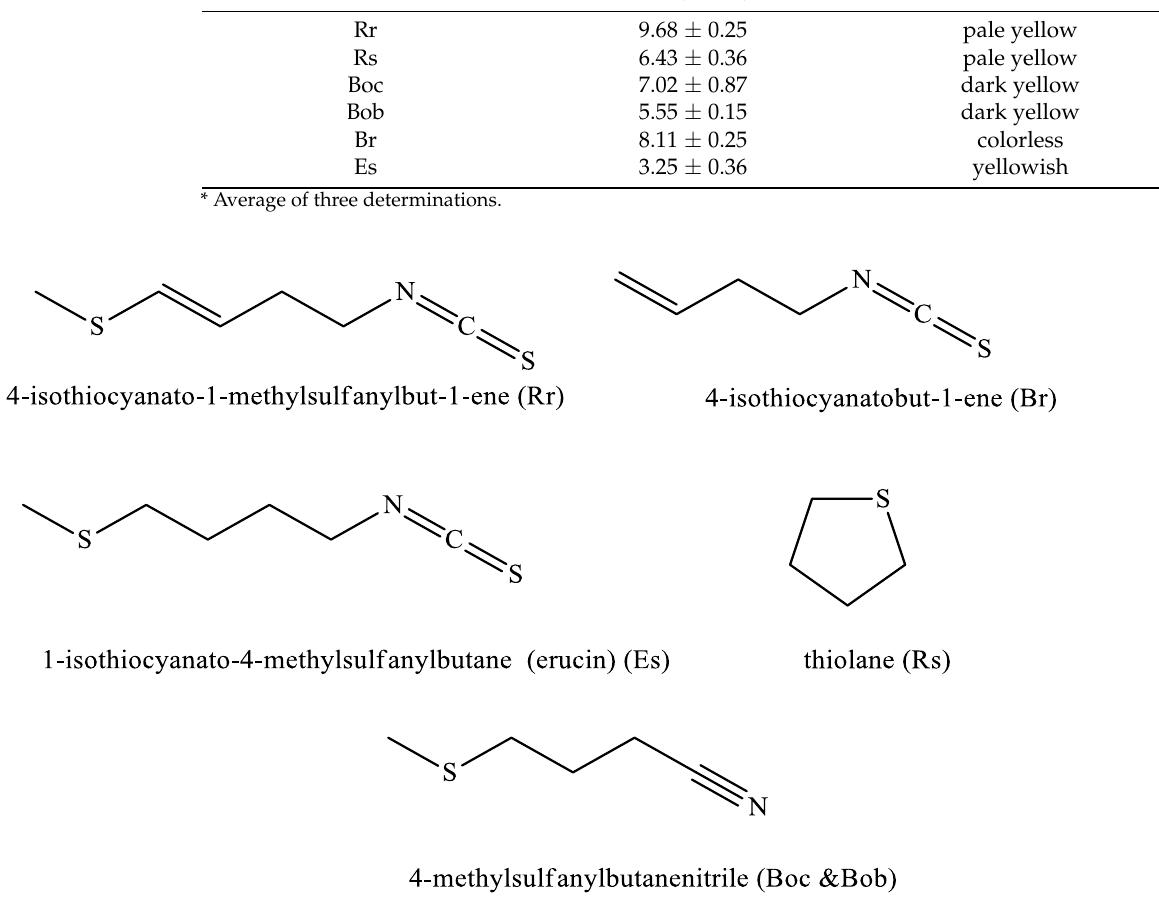
Figure 3. Major compound identified by GC/MS in the volatile oil of the studied seeds. (Rr: Raphanus